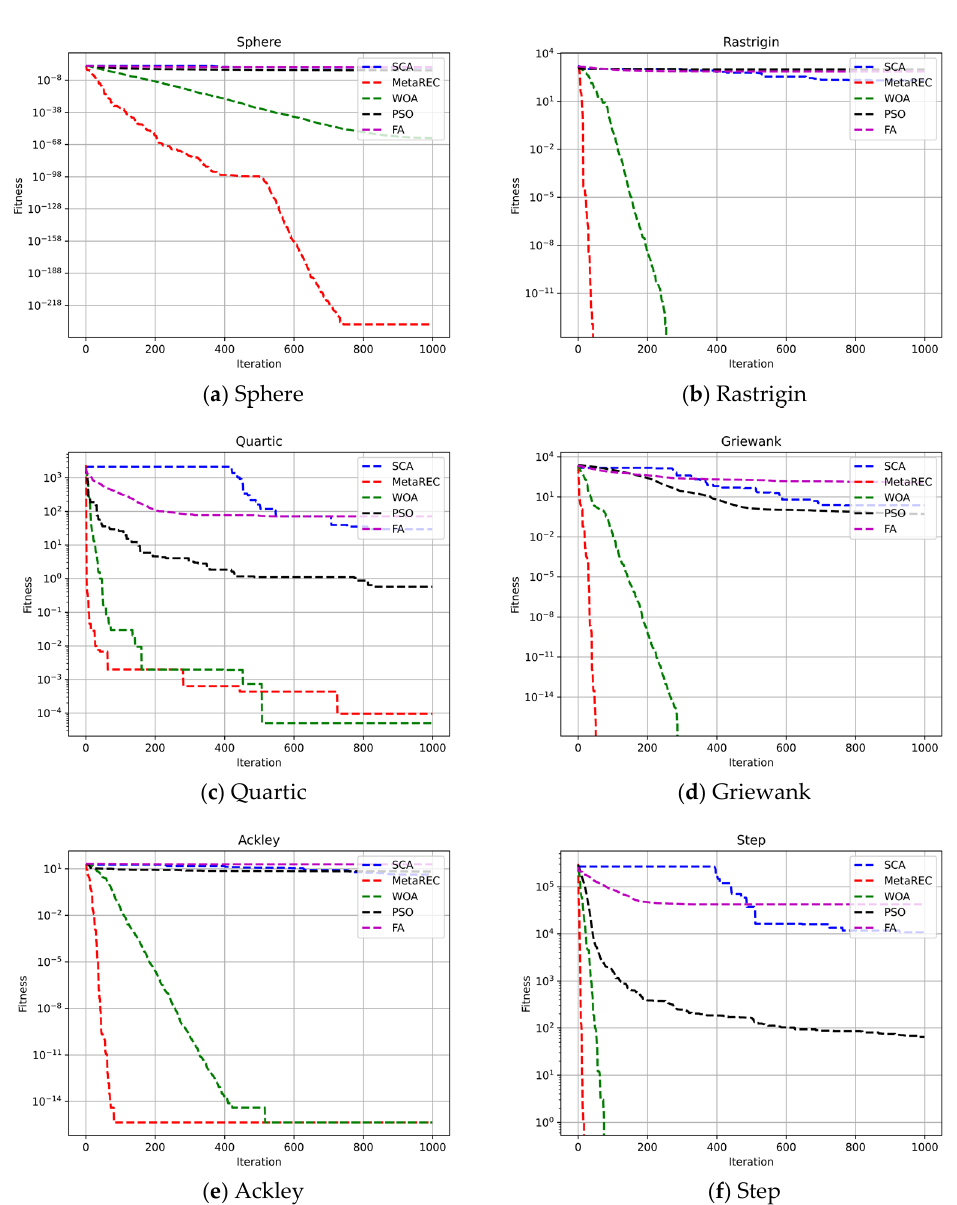
Figure 9. Comparison of the convergence of the SCA, PSO, FA, WOA, and MetaREC on test functions. ( D = 100 )